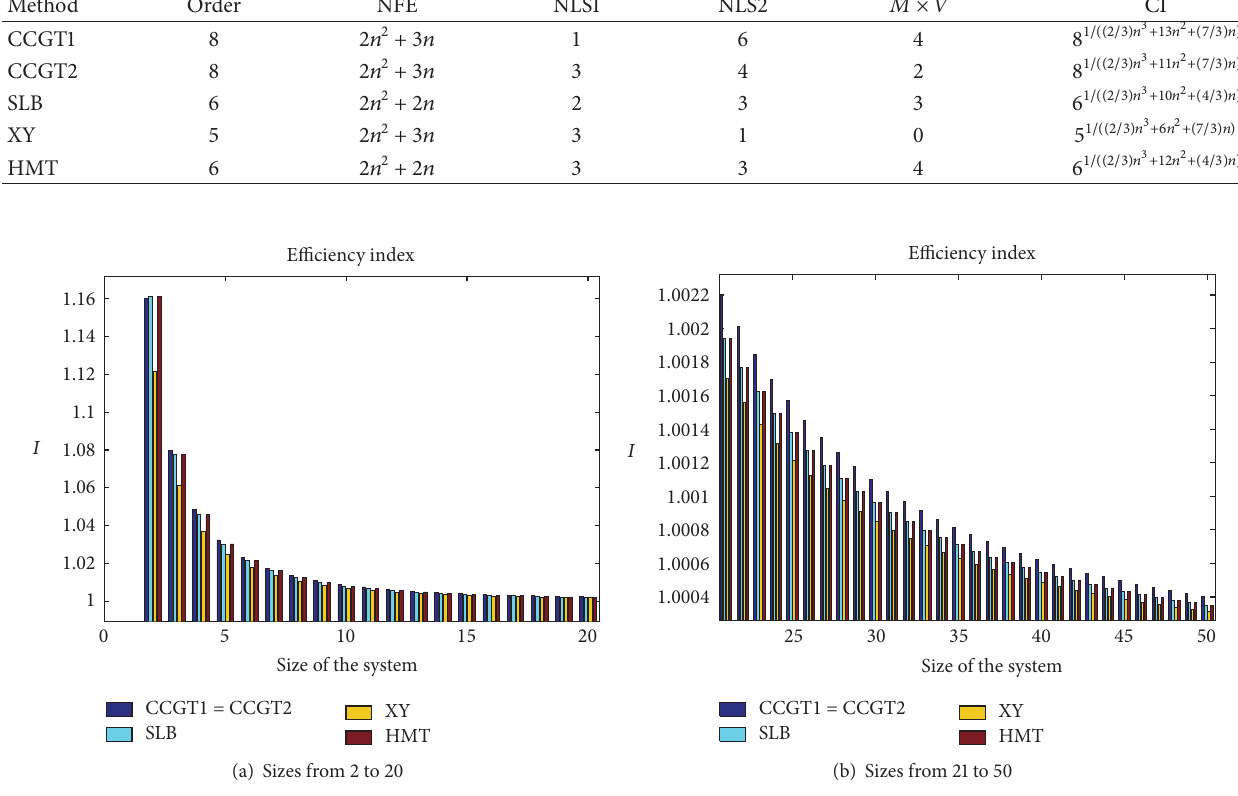
Figure 1: Efficiency index 𝐼 for different sizes of the